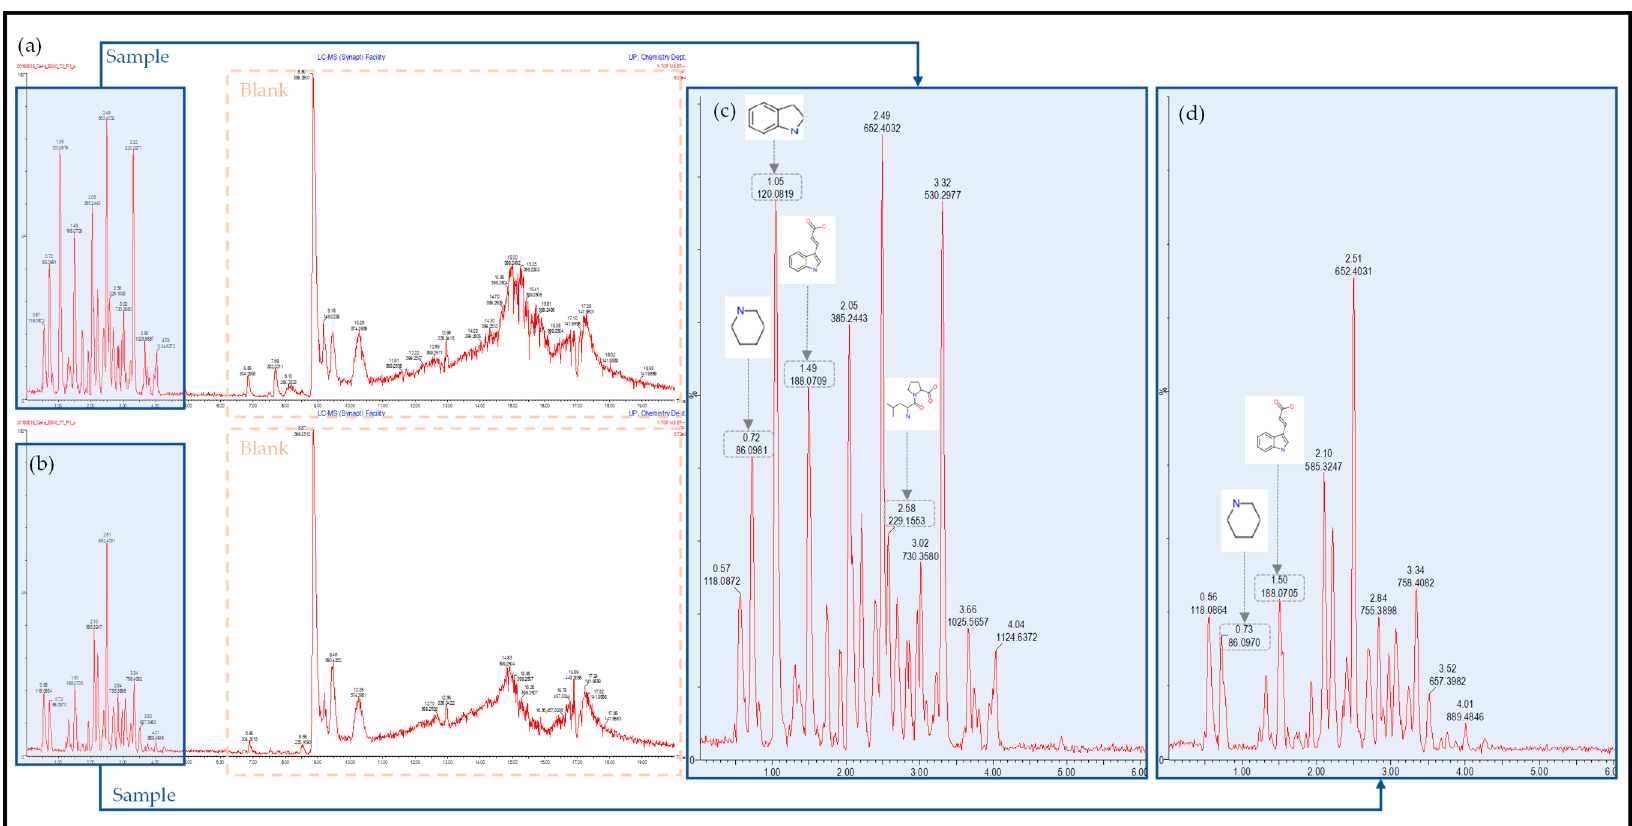
Figure 2. UPLC-HDMS chromatographs for 80 LB sample at 0 h ( a ), after 33 h ( b ), an enlarged image of the sample at 0 h ( c ) and 33 h ( d ).